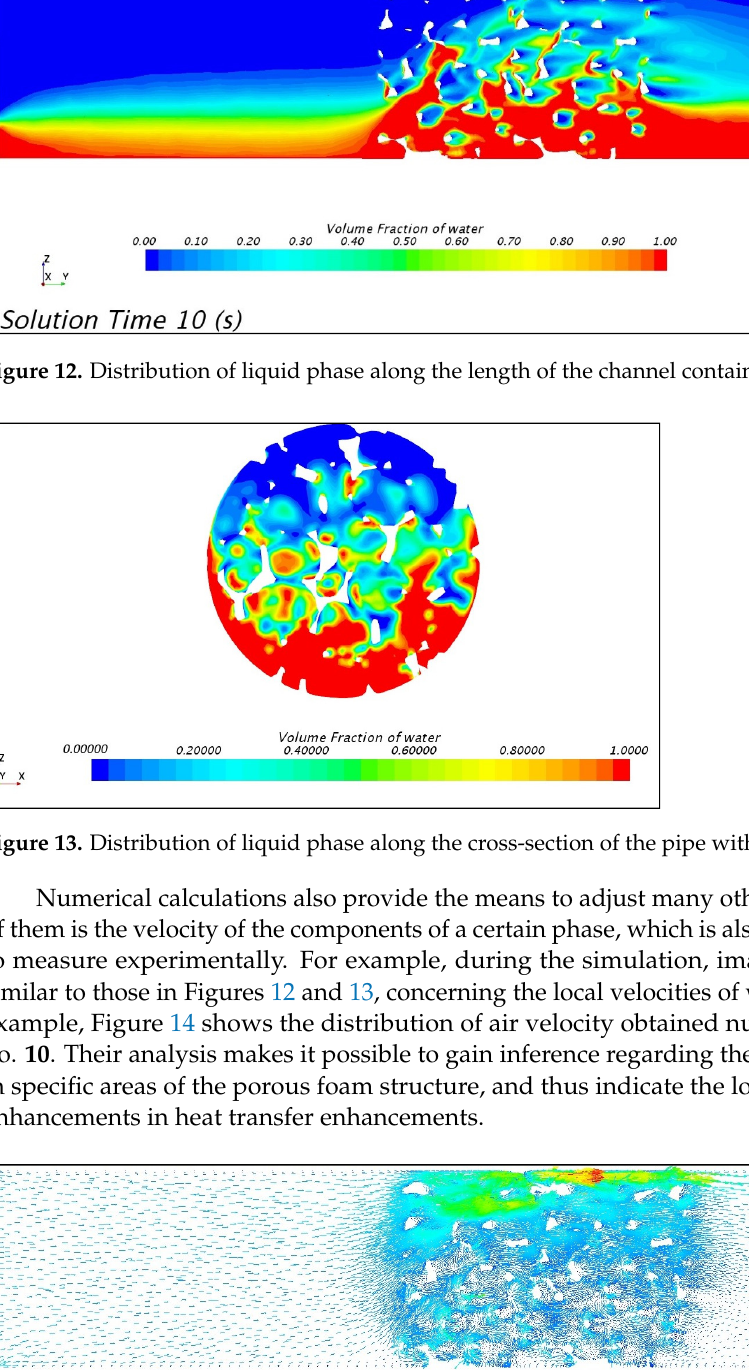
Figure 14. Distribution of air velocity in the pipe with foam packing.